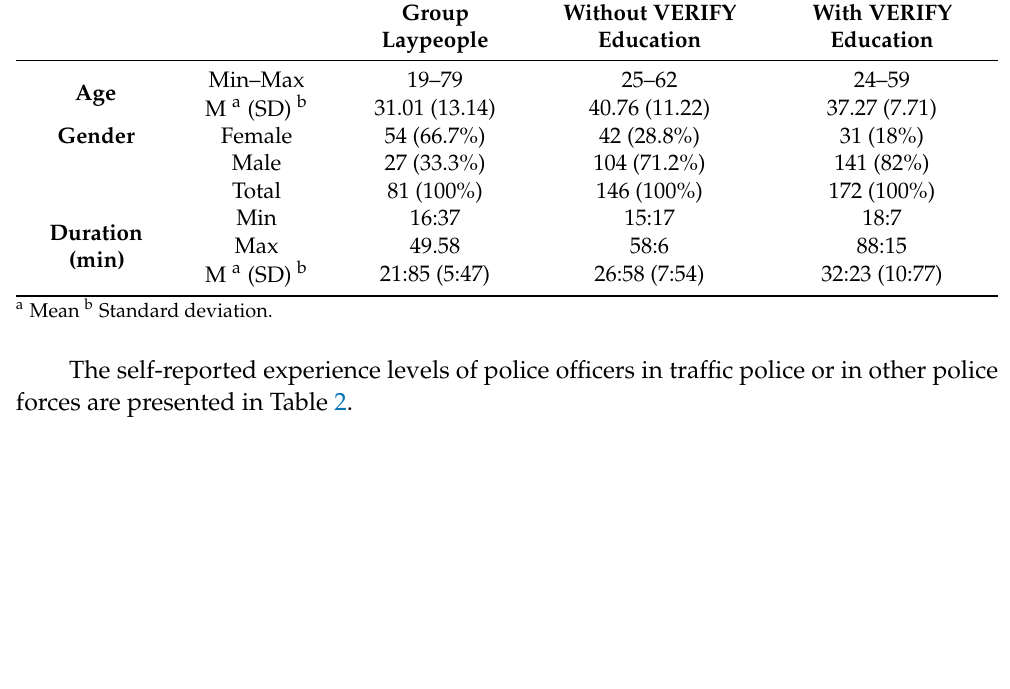
Group Without VERIFY With VERIFY Laypeople Education